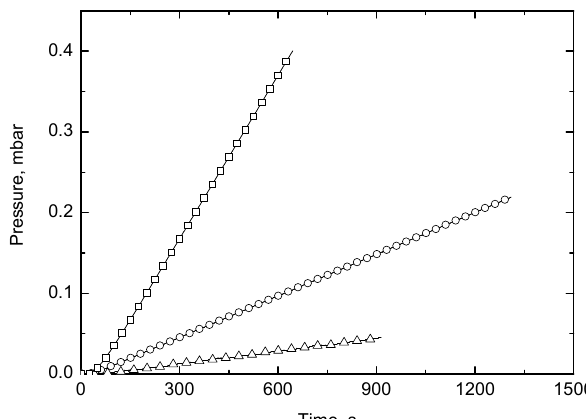
Figure 6. Evolution of the pressure of oxygen ( ○ ), nitrogen ( ), and carbon dioxide (□) in the downstream chamber as a function of time for the GPE1M membrane. Symbols and continuous lines correspond to the experimental and calculated values from Equation (5), respectively.